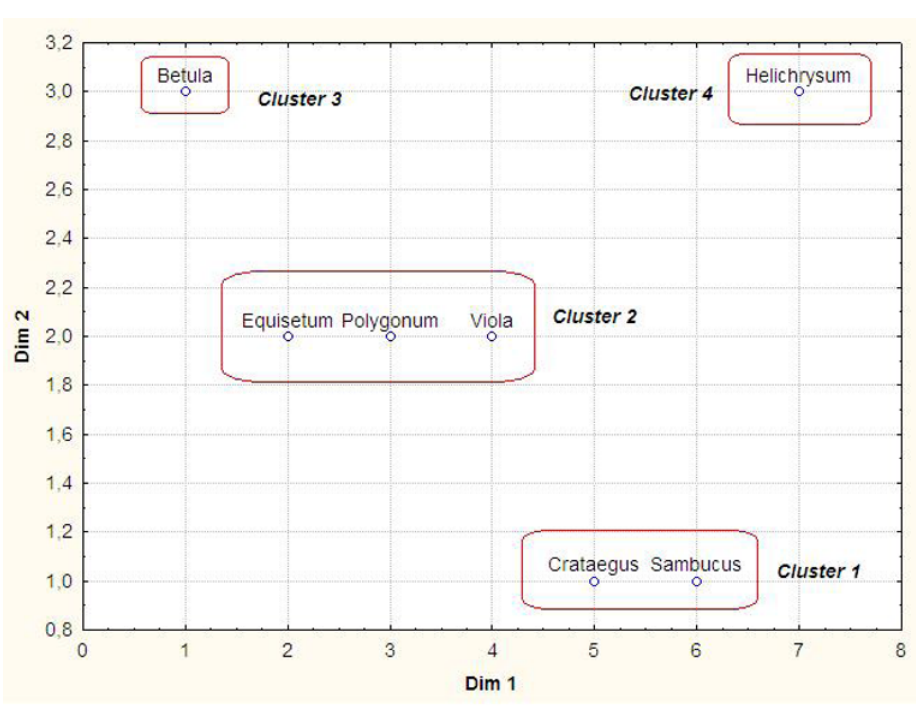
Figure 3. Classification of all samples based on the fkm analysis performed on all data set, obtained for c = 4 and m =